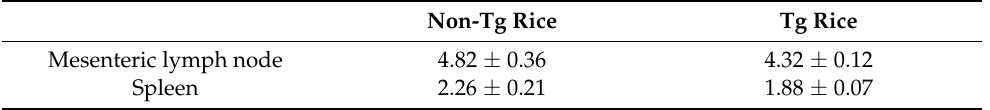
Figure 4. Release of IFN- γ ( a ) and IL-4 ( b ) by the antigen-stimulated splenocytes from mice fed Tg or non-Tg rice. Data are the means ± SEM. * p < 0.05, Tg vs. non-Tg rice-fed group according to unpaired Student’s t test (three mice per group). Table 1. Number of CD4+CD25+Foxp3+ Treg cells in mice fed Tg rice or non-Tg rice in mesenteric lymph nodes and spleens.